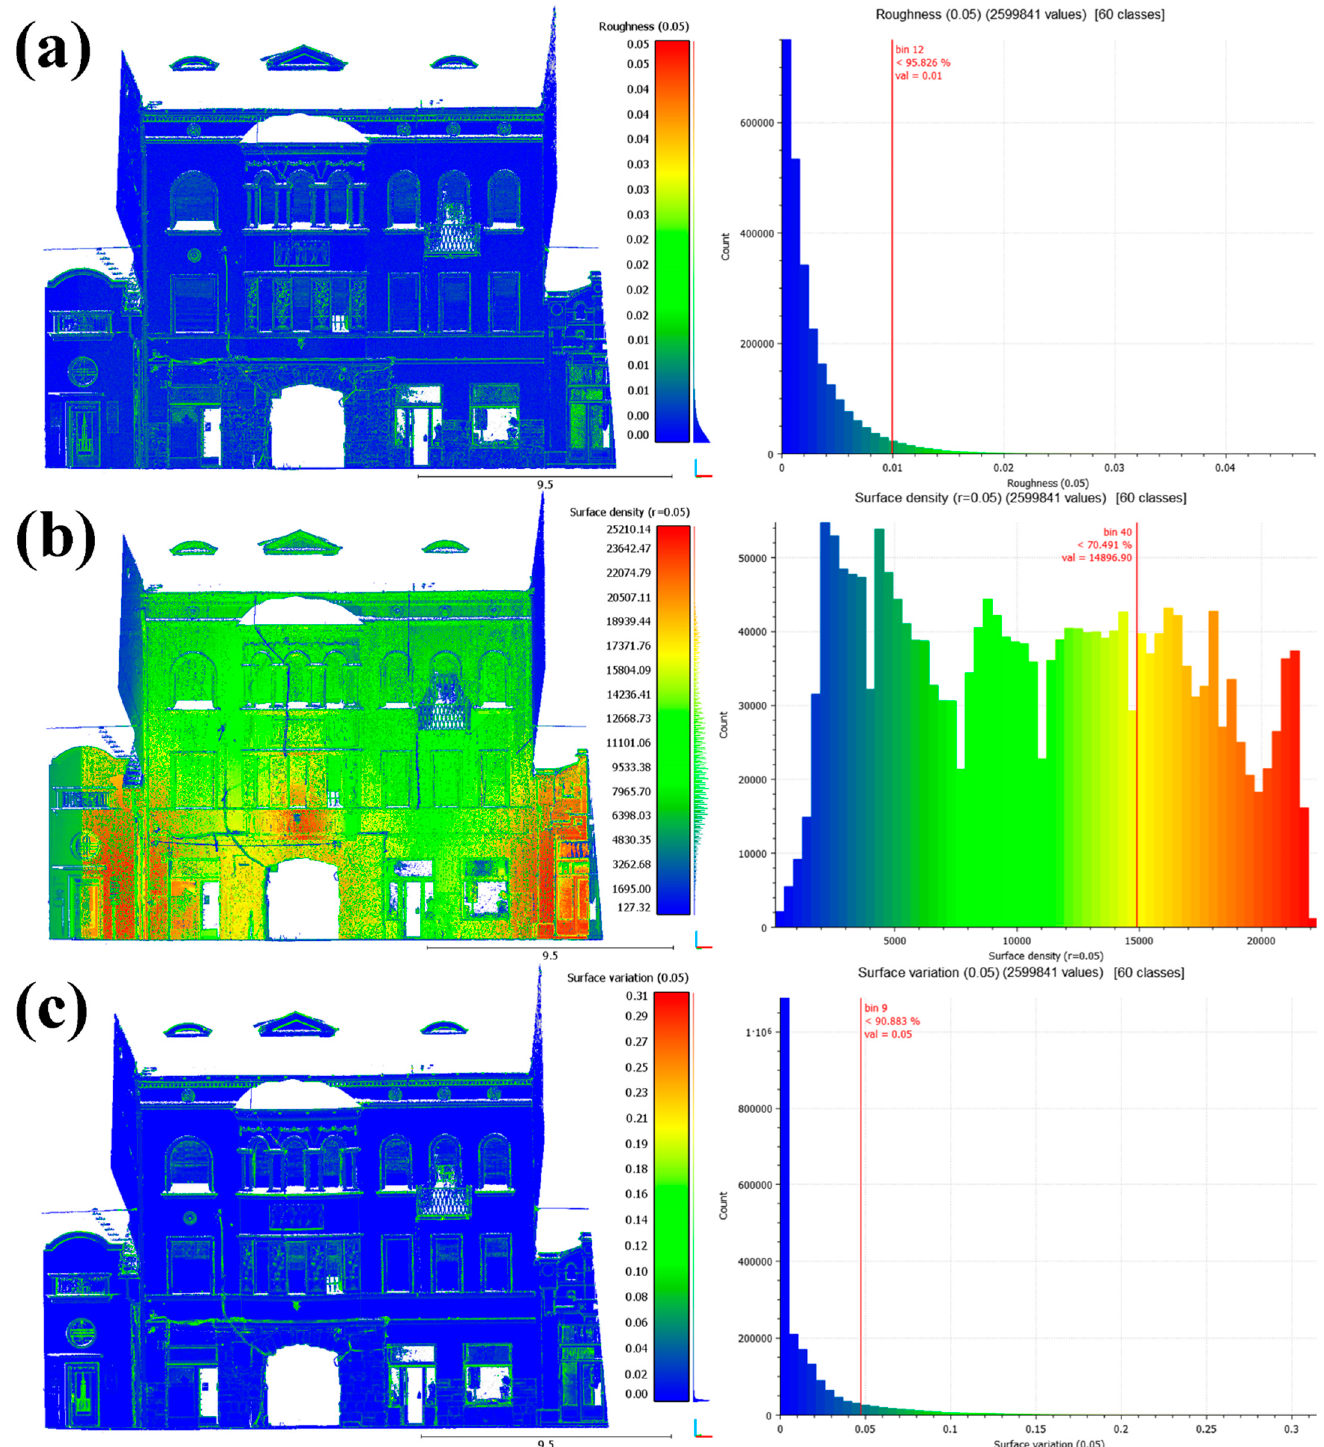
Figure 5. Determining the quality of the final point cloud of the Heyman House facade in the CloudCompare software (( a ) determining the roughness of the point cloud; ( b ) determining the surface density of the point cloud; ( c ) determining the surface variation in the point cloud).